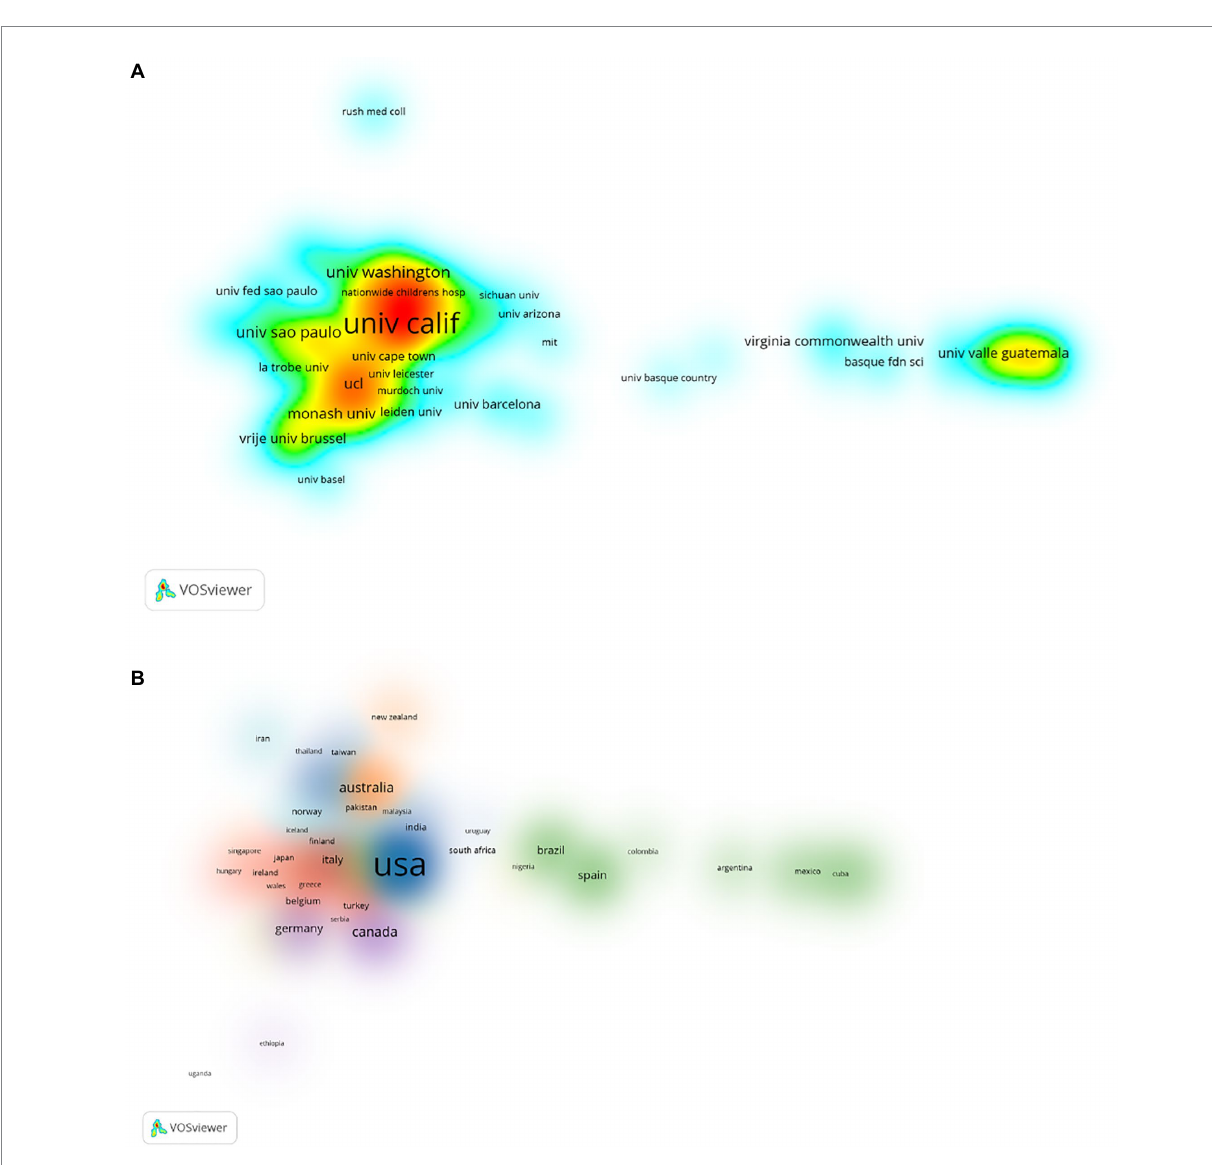
FIGURE 3 The density map of co-organizations (A) . The density map of co-country in Physiology teaching reforms (B)